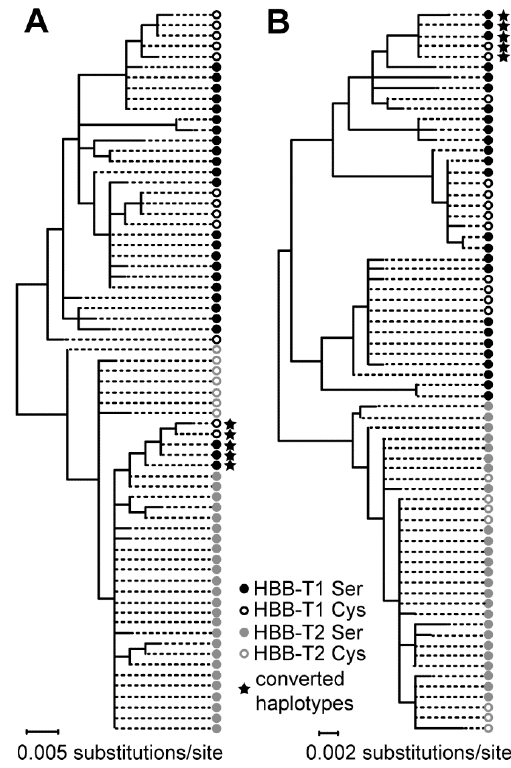
Figure 4. Schematic representation of ML trees for both HBB-T1 and HBB-T2 analysed together, representing ( A ) the converted segment of the gene spanning the sites 208–664 and ( B ) the remaining two unconverted segments of the gene (concatenated sites 1–207 and 665–1128). Haplotypes containing converted tracts in other regions were excluded.